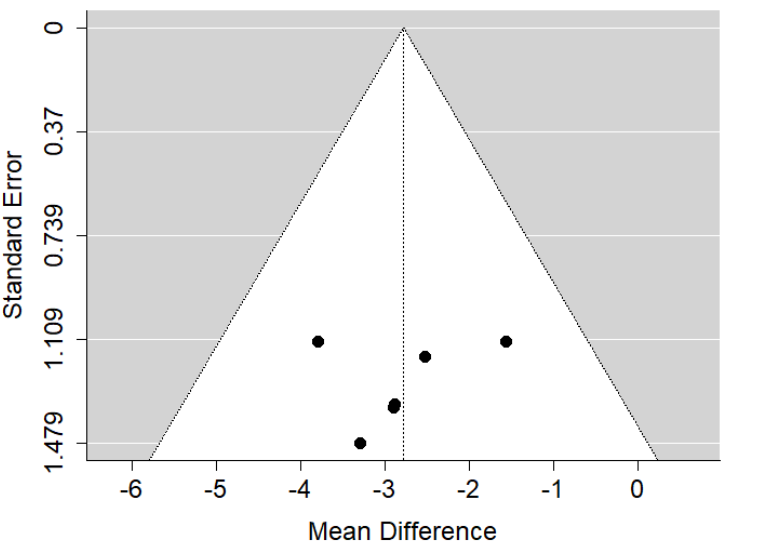
Figure 3. Funnel plot of SNA values for the comparison of patients with untreated submucous cleft palate vs. non-cleft healthy population [18,21,24,25].